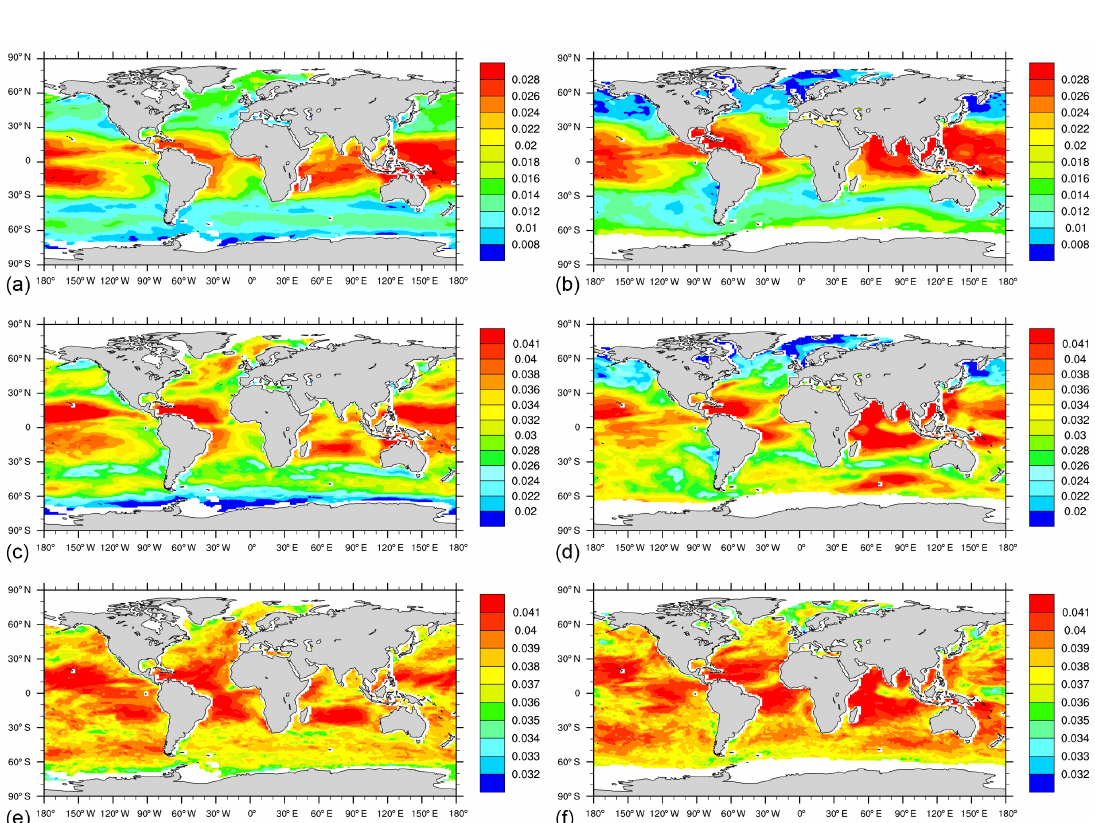
Figure 10. Modelled ozone dry deposition velocity ( v d , cms − 1 ). The left panels (a, c, e) are for January 2006 and right panels (b, d, f) are for July 2006. Top panels (a, b) are from the two-layer reactivity scheme, middle panels (c, d) are from the one-layer reactivity scheme, and bottom panels (e, f) are from the default scheme with surface resistance r c = 2200sm − 1 . Note differences in